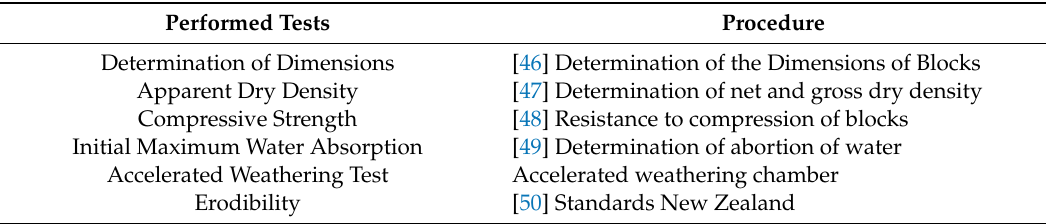
Table 4. Erodibility indices.